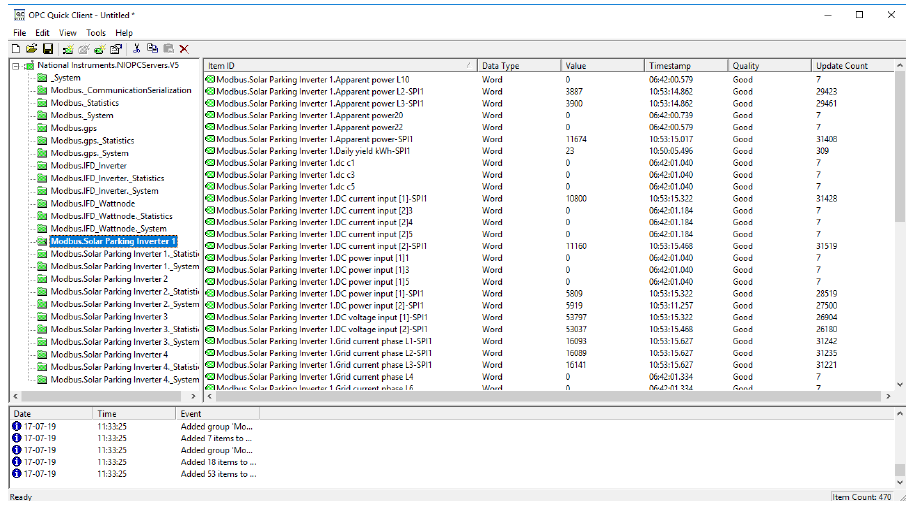
Figure 14. OPC Quick Client for debugging and troubleshooting.